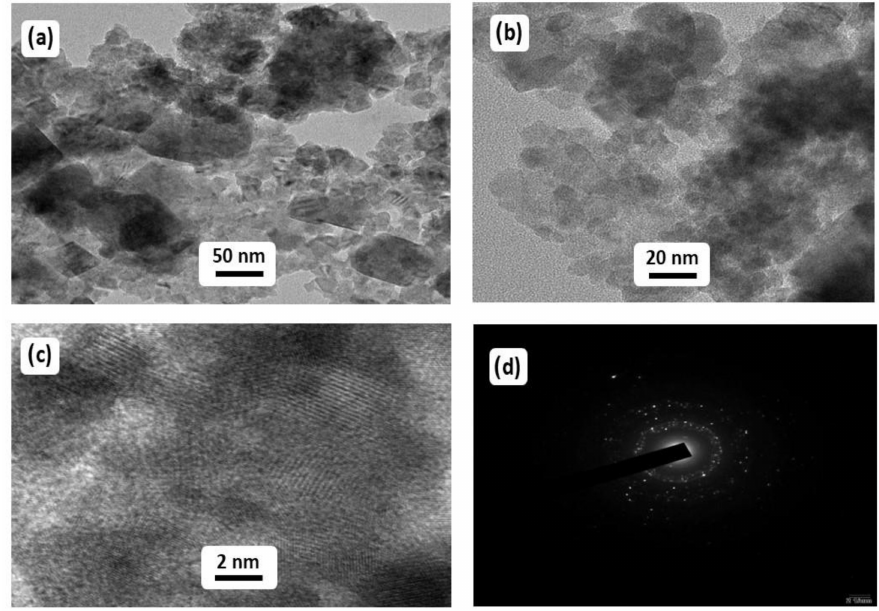
Figure 6. HRTEM images of the prepared Mn 3 O 4 /ZnO/Eu 2 O 3 nanocomposite. ( a ) 50 nm, ( b ) 20 nm ( c ) 2 nm and ( d ) SAED